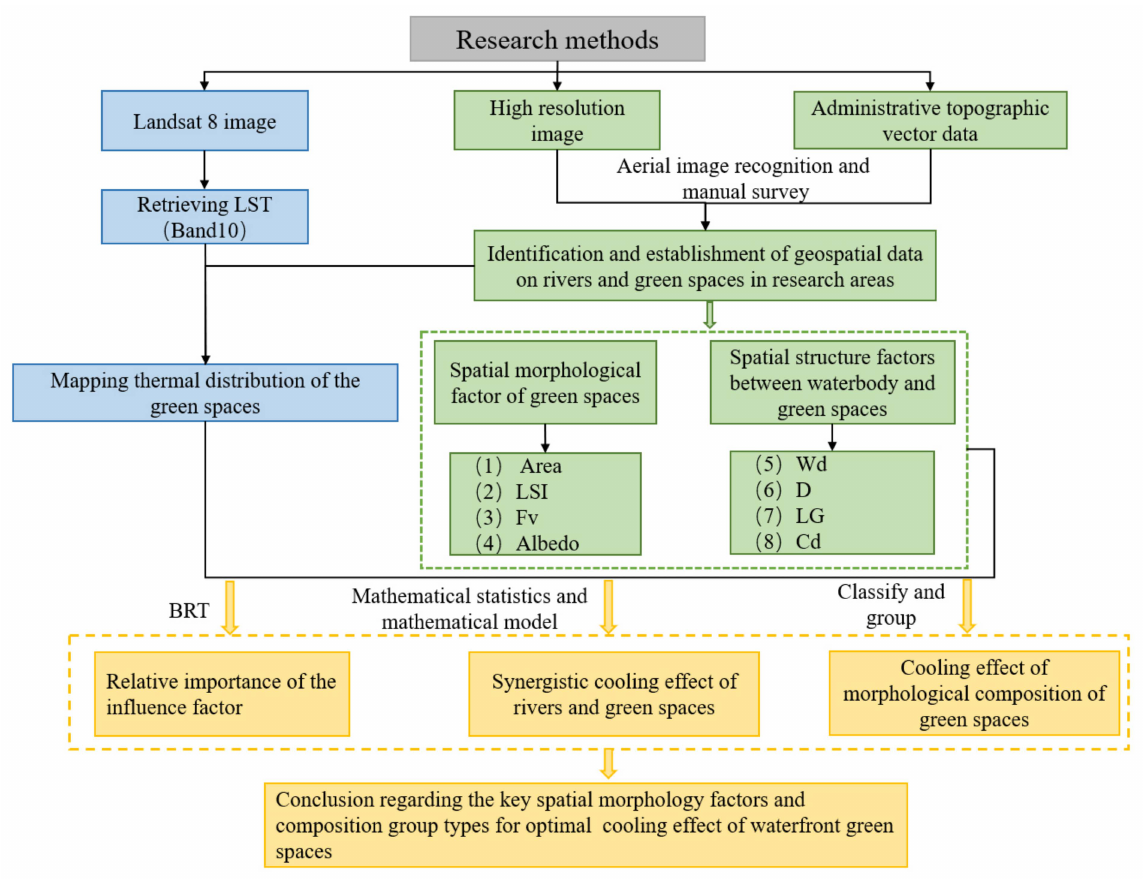
Figure 2. Process flow of the study. BRT: boosted regression trees; LSI: landscape shape index; Fv: fractional cover values of vegetation space; Wd: width of river; D: distance to riverbank; LG: location of greenspace; Cd: connectivity